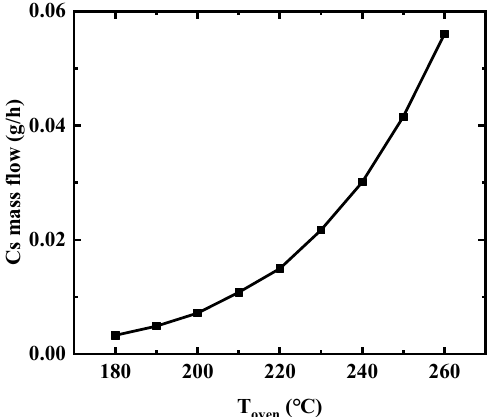
Figure 12. The calculated Cs flux of the oven at different temperatures.